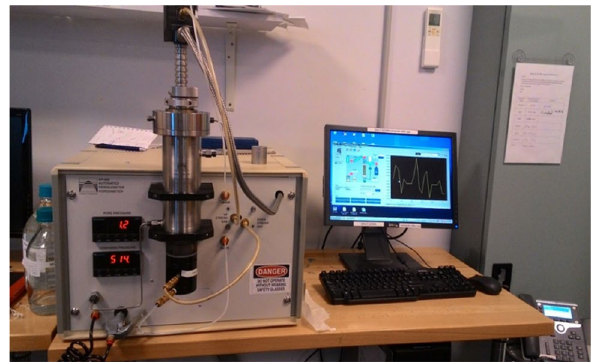
Fig. 4 Automated